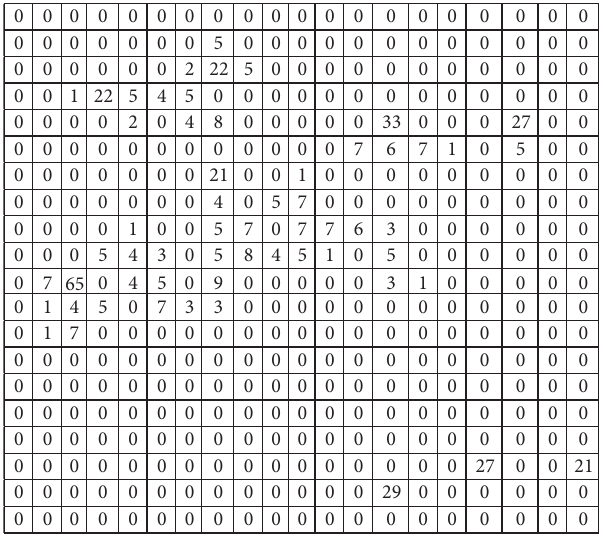
Figure 3: The 𝑦 -values.